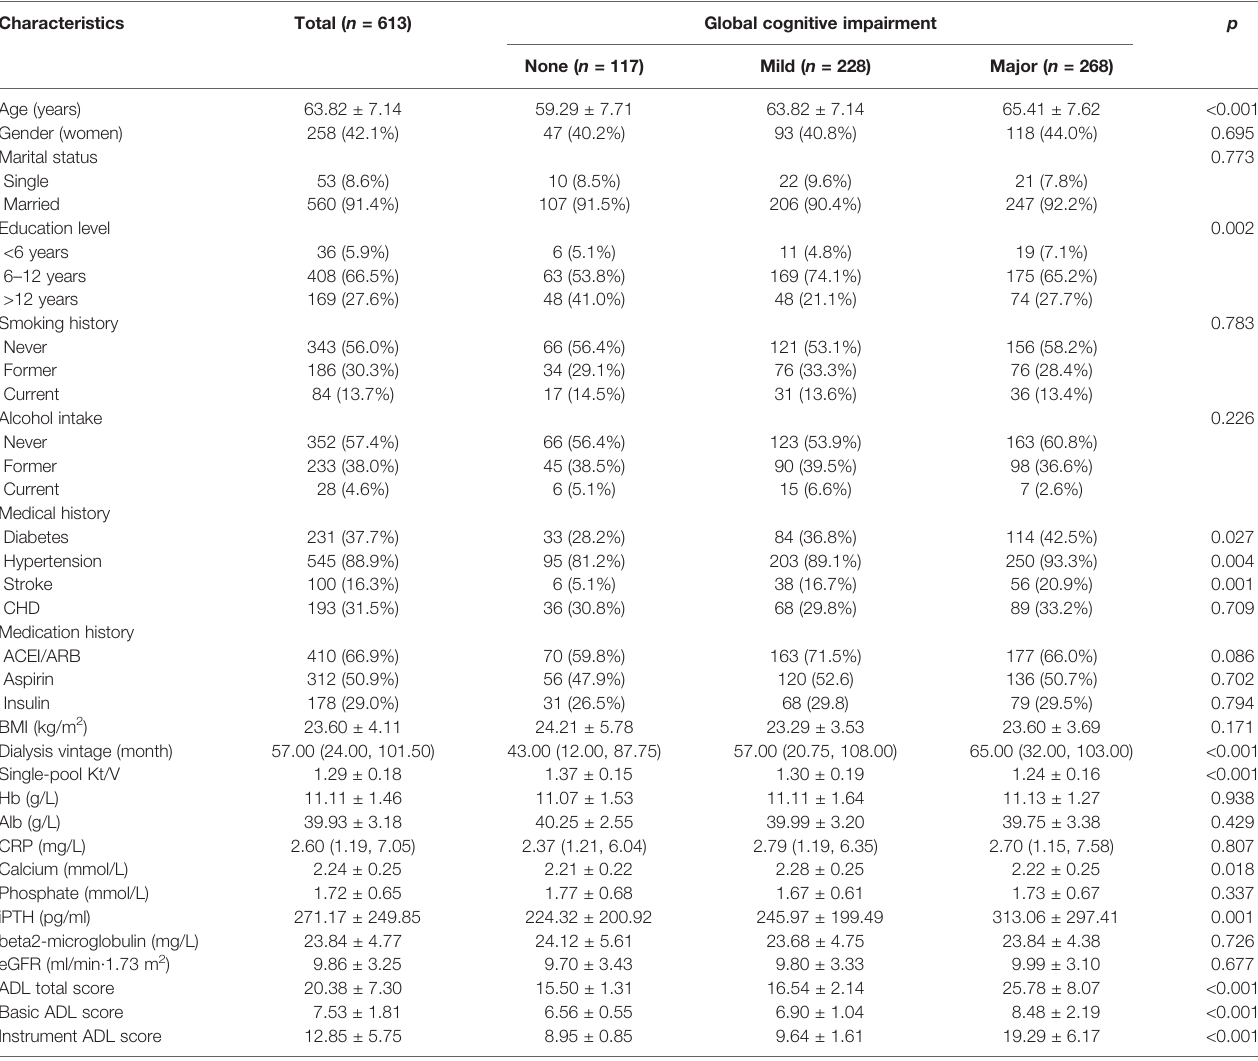
TABLE 1 | Baseline characteristics of the participants with different global cognitive functions. Characteristics